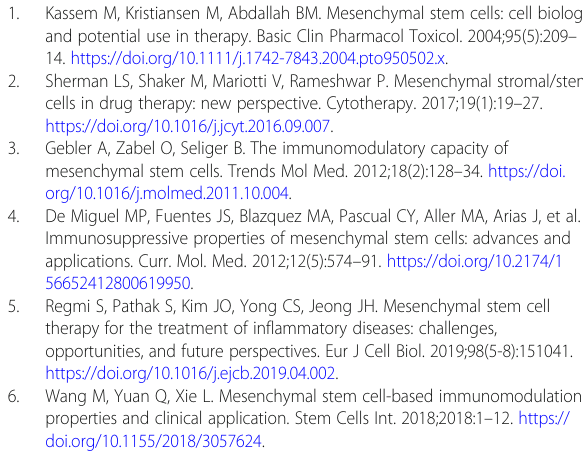
Additional file 1: Supplementary Table 1. Information of MSCs used in this study. Additional file 2: Supplementary Figure 1. Schematic illustration of image processing